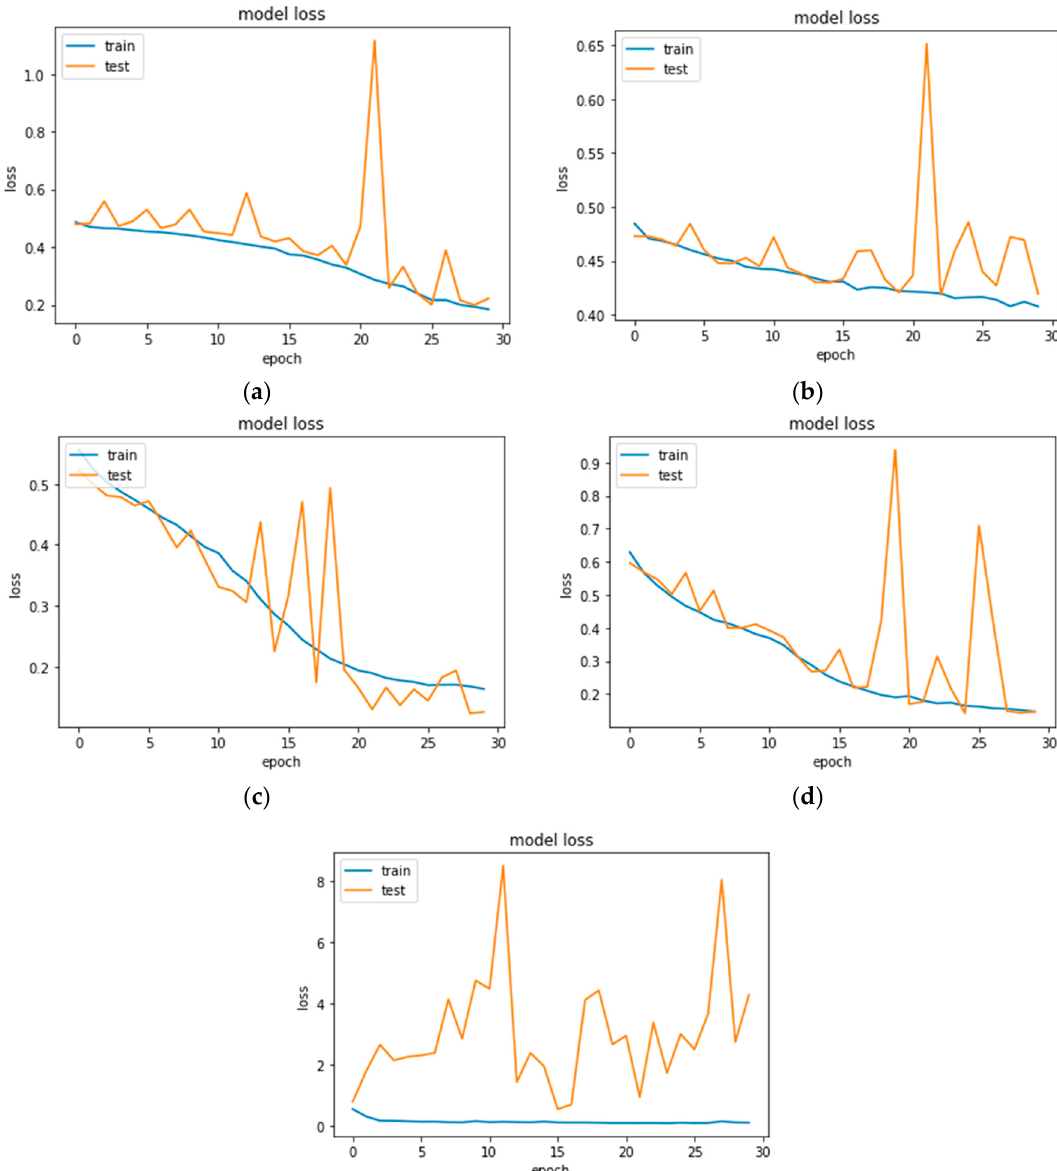
Figure 10. Plots of accuracy models for ( a ) 1-CNN, ( b ) 2-CNN, ( c ) 3-CNN, ( d ) 4-CNN, and ( e ) Trans- fer learning with ResNet50.